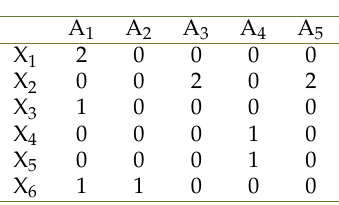
Table 2. Decision matrix